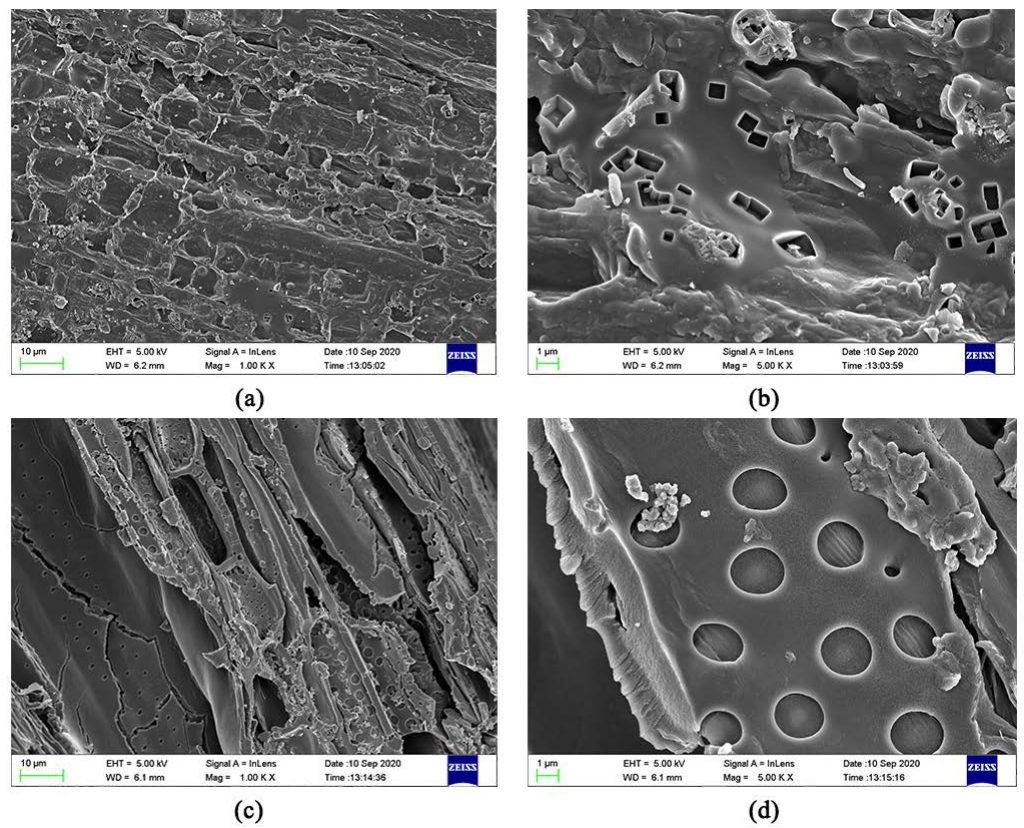
Figure 11. SEM images of JB after adsorption. ( a ) for adsorption of NO 3 − at 1000 times; ( b ) for adsorption of NO 3 − at 5000 times; ( c ) for adsorption of NH 4 + at 1000 times; ( d ) for adsorption of NH 4 + at 5000 times.